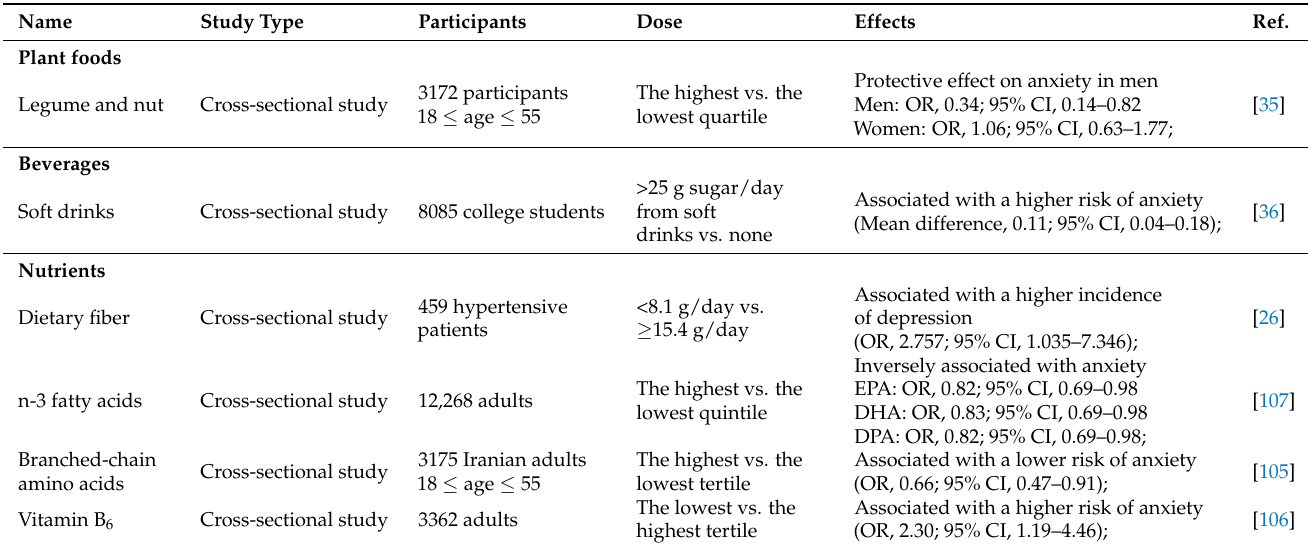
Table 3. Effects of dietary natural products and nutrients on anxiety from epidemiological